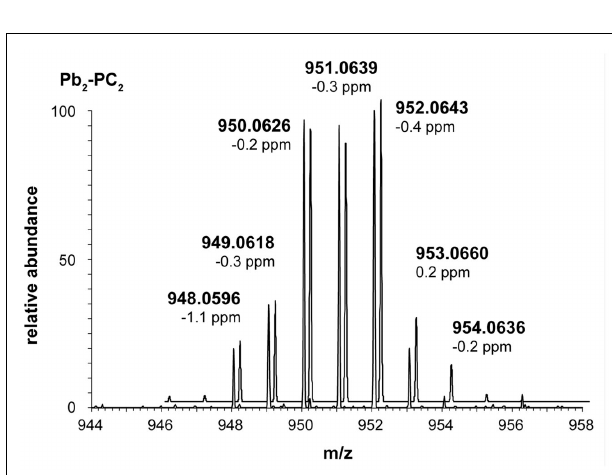
FIGURE 3 | Measured (front) and simulated spectrum (back) of the isotopic pattern of the [Pb 2 –PC 2 ] + complex m / z 944–958. Isotopic distribution of two Pb ( 204 Pb 1.5; 206 Pb 23.6; 207 Pb 22.6; 208 Pb 52.3%) is identified in the peak distribution of the m / z